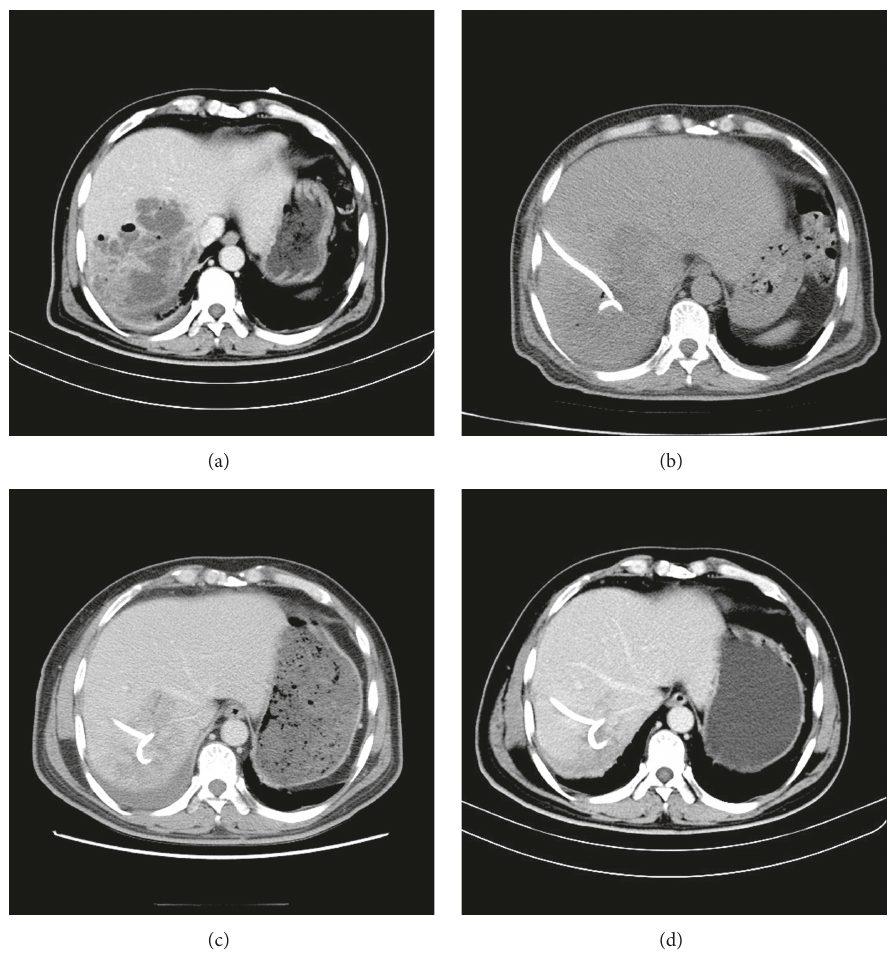
Figure 2: A 43-year-old male presented with fever and right abdominal pain for five days. (a) Enhanced CT shows a lager multiloculated liver abscess in the right hepatic lobe. The abscess cavity has gas formation, which is associated with mortality. (b) Catheter was placed under CT guidance. (c) After the pus was pulled out, oxygen-ozone gas mixture was given through catheter and filled the small locules of the abscesses; some separation was broken. (d) Abscess was absorbed after three weeks.